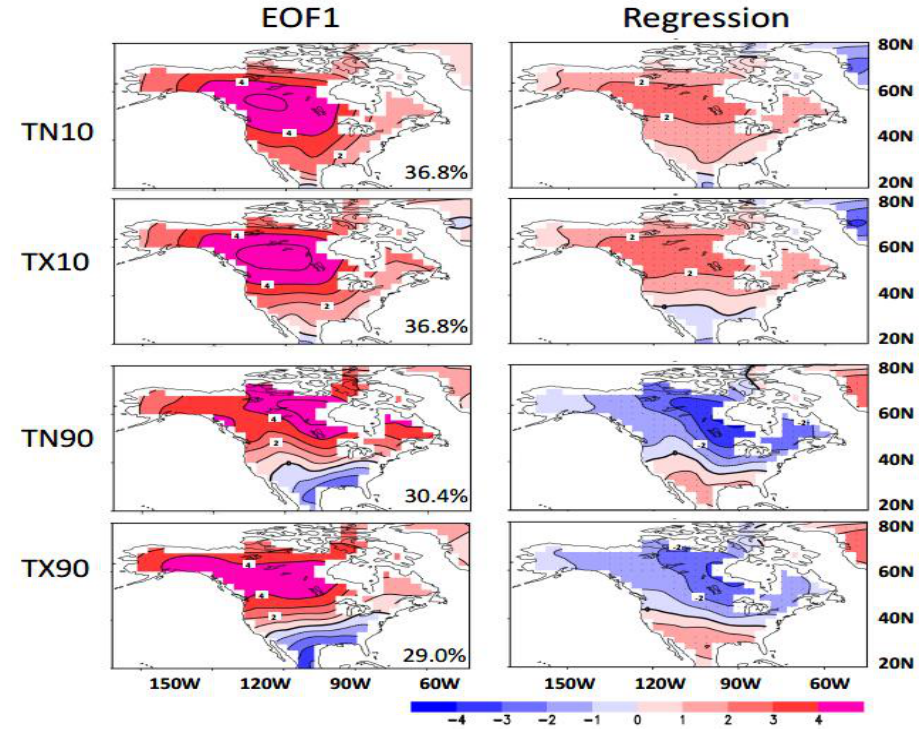
Figure 9. As in Figure 7, but for the results over North America. The cyclone activity series used in regressions is the linearly de-trended and standardized ensemble mean cyclone intensity series.